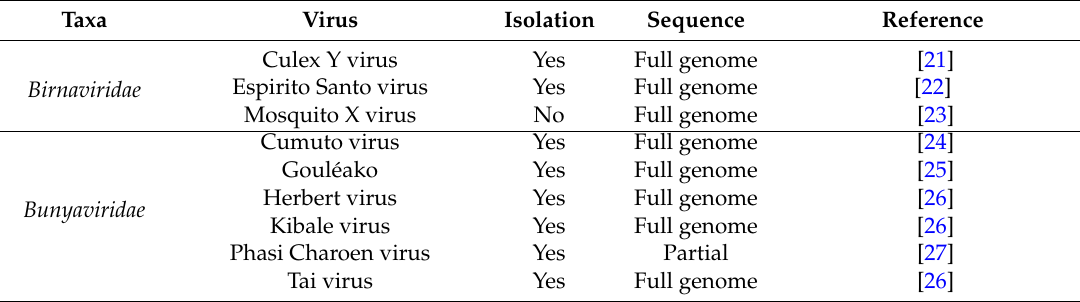
Table 1. Insect-specific viruses described in the